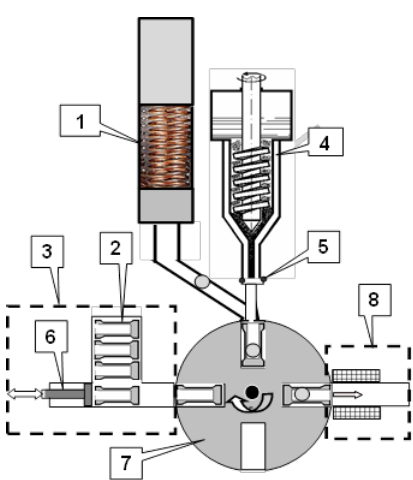
Figure 7. Repeatable assembly of the FST-projectile for safe noncontact delivery of the free-standing targets at the laser focus.